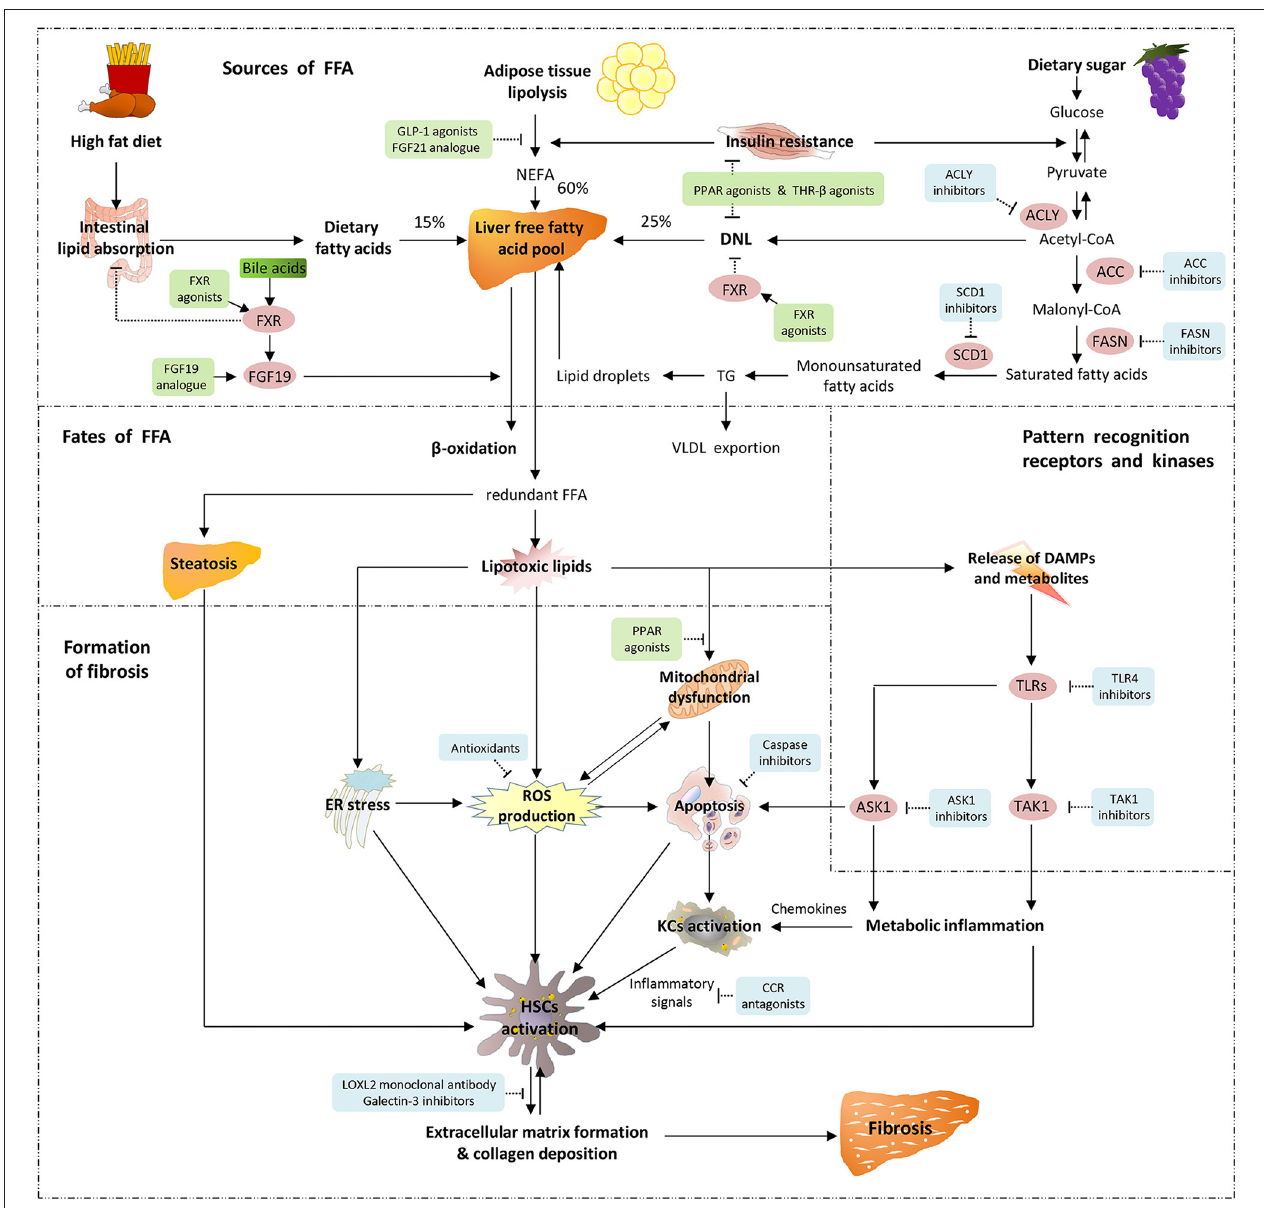
FIGURE 1 | Pathogenetic mechanisms underlying fibrosis in MAFLD/NAFLD and molecular target of drug therapy. There are three sources of hepatic free fatty acids (FFA): 60% from the adipose tissue lipolysis or non-esterified fatty acid (NEFA) pool, 25% from de novo lipogenesis (DNL), and the remaining 15% from the intestinal absorption of diet. The two main metabolic pathways of hepatic FFA are mitochondria-mediated β -oxidation and esterification to form triglyceride (TG). Triglyceride is able to be exported into the circulation in the form of very-low-density lipoprotein (VLDL), and the excessive TG are stored in lipid droplets. When FFA are overaccumulated or their disposal is not timely, the redundant FFA act as substrates to produce lipotoxic lipids, which lead to endoplasmic reticulum (ER) stress, production of reactive oxygen species (ROS), impaired mitochondrial function and release of danger-associated molecular patterns (DAMPs). Pattern recognition receptors such as toll-like receptors (TLRs) sense the continuous production of DAMPs and metabolites, thereby triggering downstream signaling pathways. Apoptosis signal-regulating kinase 1 (ASK1) and TGF- β -activated kinase 1 (TAK1) are crucial intracellular signal transduction components that are activated by post-transcriptional modification, and further activate their downstream pivotal kinases and transcription factors, leading to the occurrence of metabolic inflammation. As metabolic stress leads to the expression and release of inflammatory chemokines, Kupffer cells (KCs) polarize into pro-inflammatory phenotypes and participate in the activation of hepatic stellate cells (HSCs) in coordination with ROS, apoptotic signals and ER stress. These exacerbate extracellular matrix formation and collagen deposition, and result in liver fibrosis. Emerging therapeutic agents and their molecular targets for fibrosis in MAFLD/NAFLD are also indicated. Agonists and analogs are marked in green, while antagonists, inhibitors and antibodies are marked in